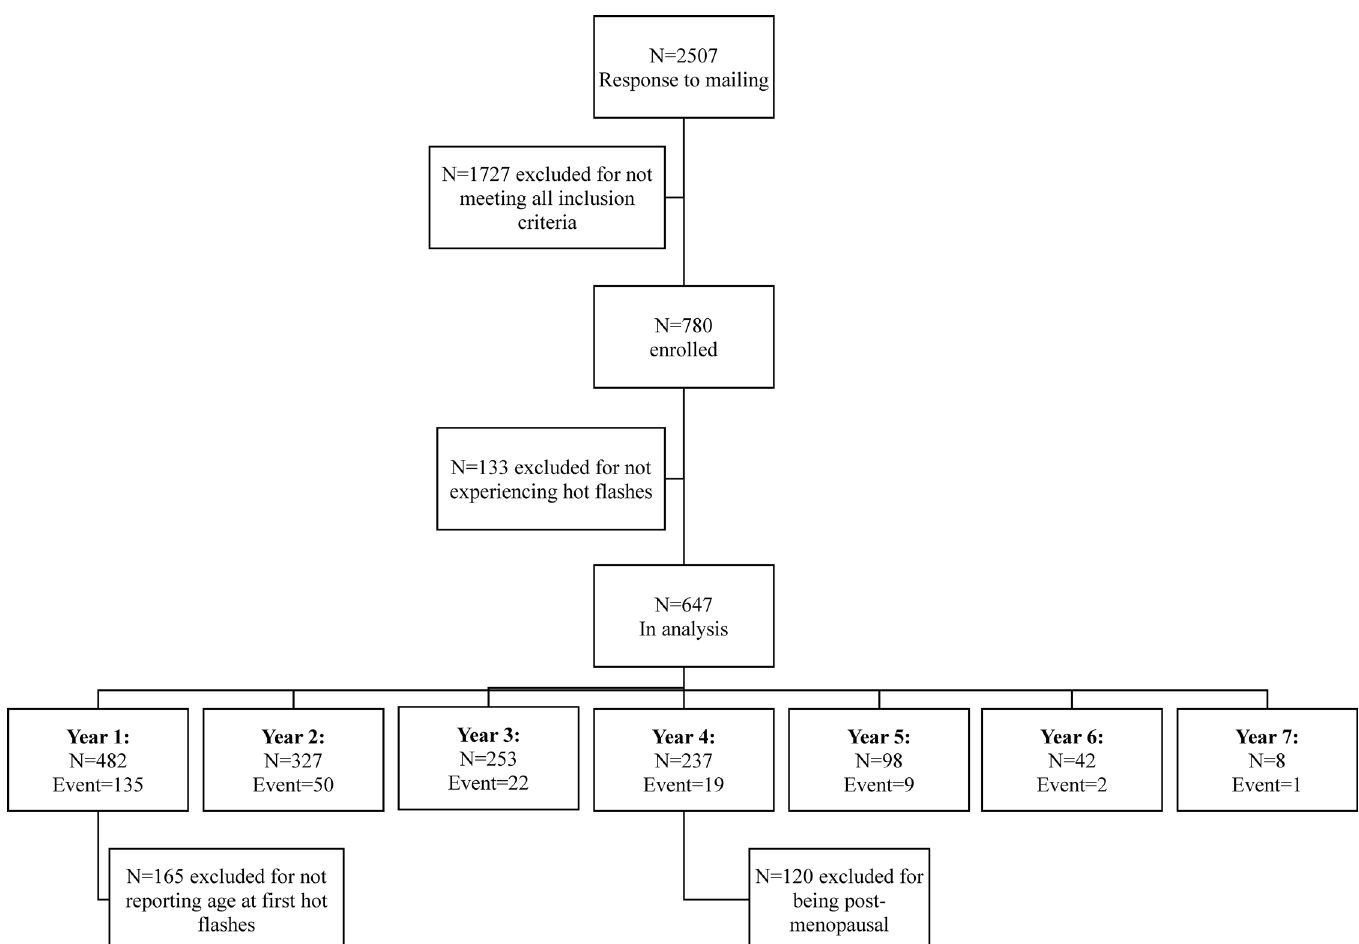
Fig 1. Flow chart of women enrolled in the study. Event indicates that hot flashes ended during that